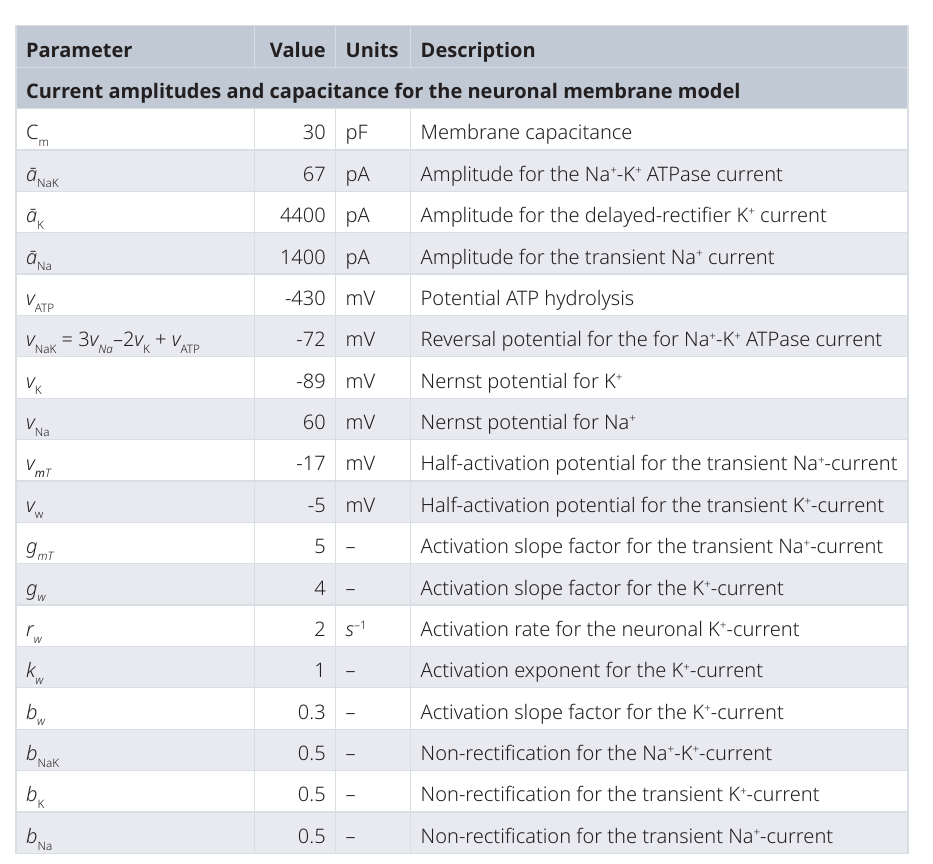
Table 4. Parameters for the fast spiking interneuron